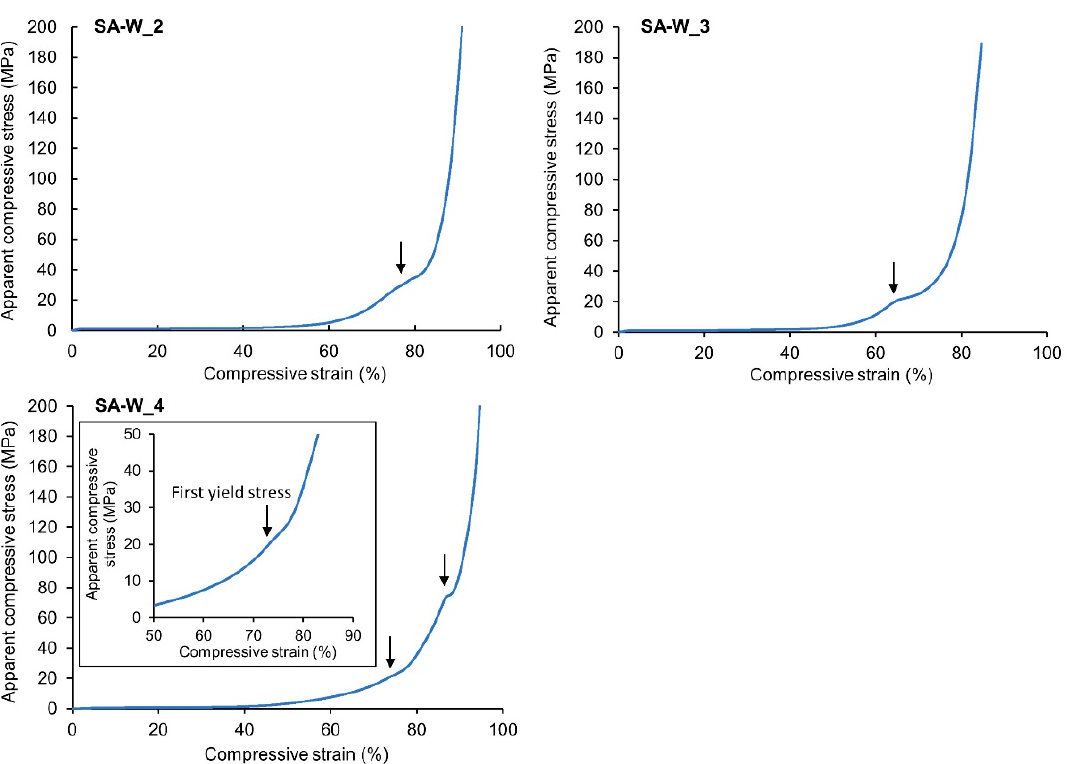
Figure 8. Compressive stress–strain curves of degreased and propionylated wood specimens. The arrows indicate yield stresses. For specimens TFAA-W and SA-W_4 , an enlarged view of the stress–strain curve near the first yield stress is also shown.